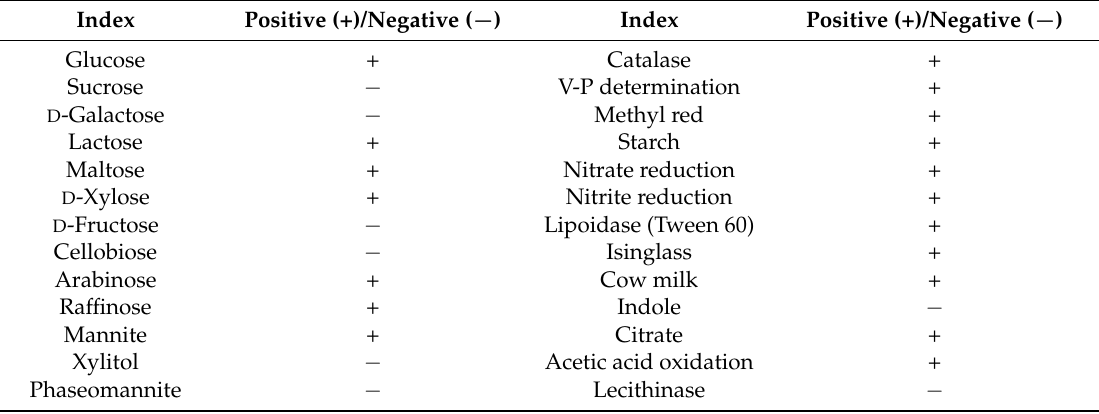
Table 3. Physiological and biochemical identification results of the most important strain isolated from